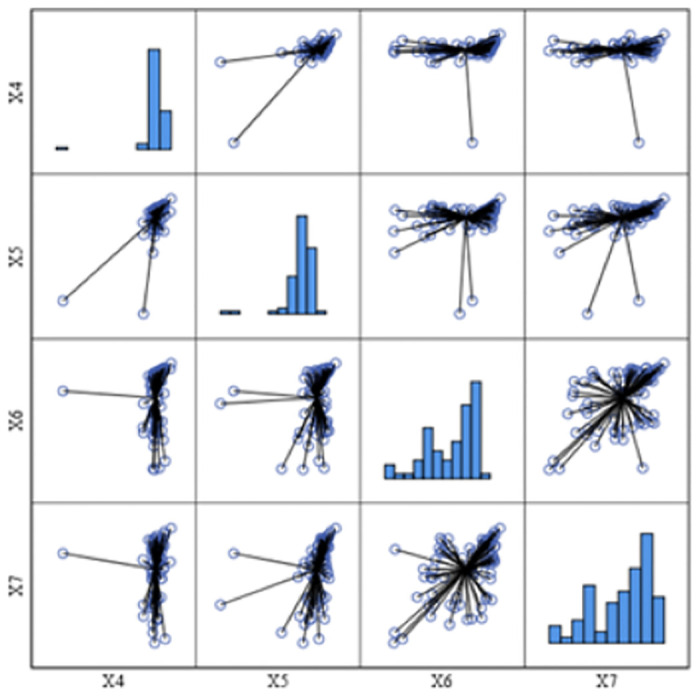
Distribution matrix of ci for the indicators X4 –X7.